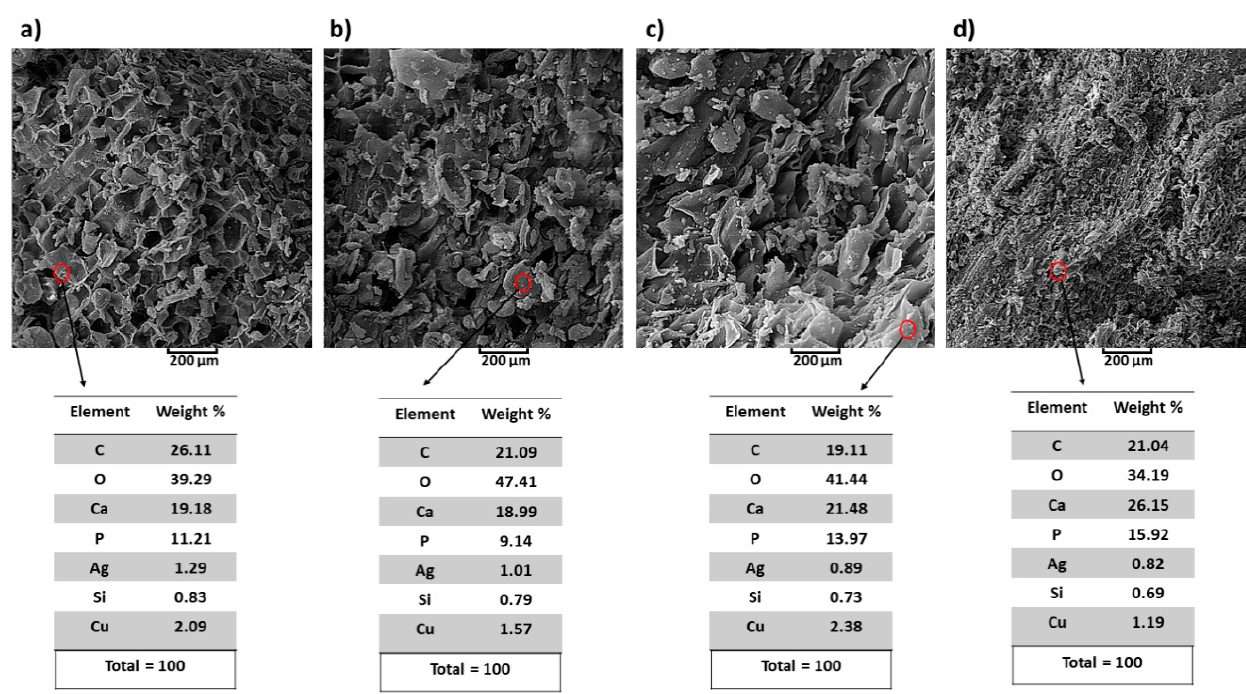
Figure 16. SEM EDAX data of immersed scaffold in SBF after ( a ) 3 days, ( b ) 5 days, ( c ) 10 days and ( d ) 20 days.